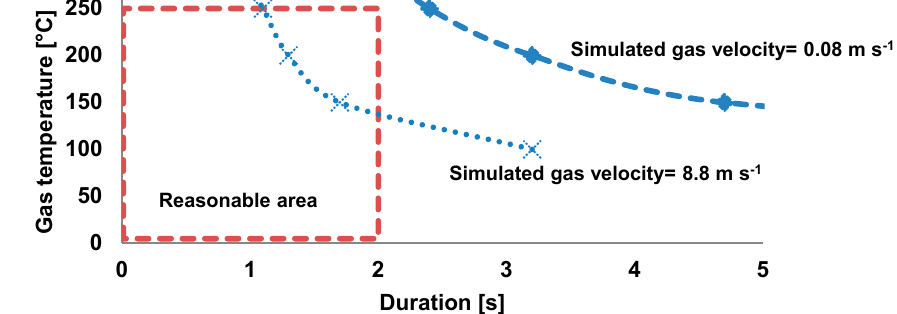
Figure 6. Two temperature curves for a model seed (80 ° C in the middle of the seed) in relation to the gas temperature, the velocity of the gas and the time of exposure. The red marked area indicates the combinations of temperature and duration that are realistic to obtain with a commercial grain harvester.